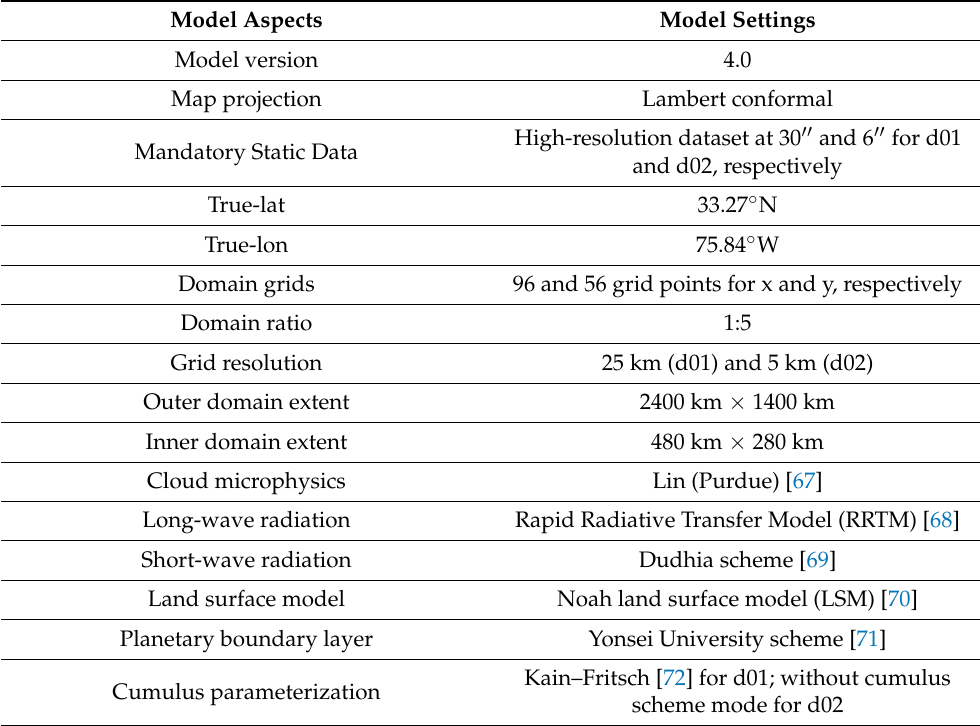
Table 3. Summary of the WRF model grids configuration and physics